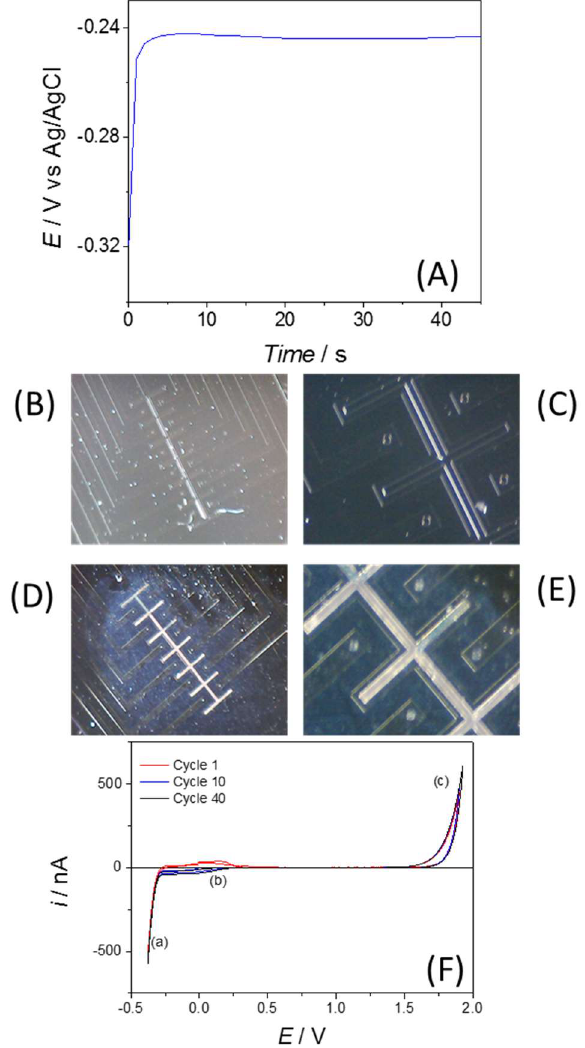
Figure 2. ( A ) Chronopotentiogram resulting from galvanostatic silver plating ( − 500 nA) of the on-chip reference electrode in 2.0 M potassium thiocyanate and 10 mM silver nitrate vs. an external Ag/AgCl/Cl − (3.5 M) reference electrode. ( B – E ) Images of electrode devices—unplated × 20 ( B ) and × 80 ( C ) and following plating and Ag/AgCl functionalization × 20 ( D ) and × 80 ( E ). ( F ) Cleaning voltammogram of Pt microelectrodes in 0.1 M sulfuric acid.